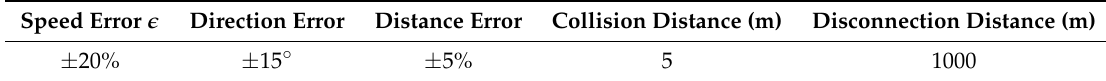
Table 2. Errors and distance